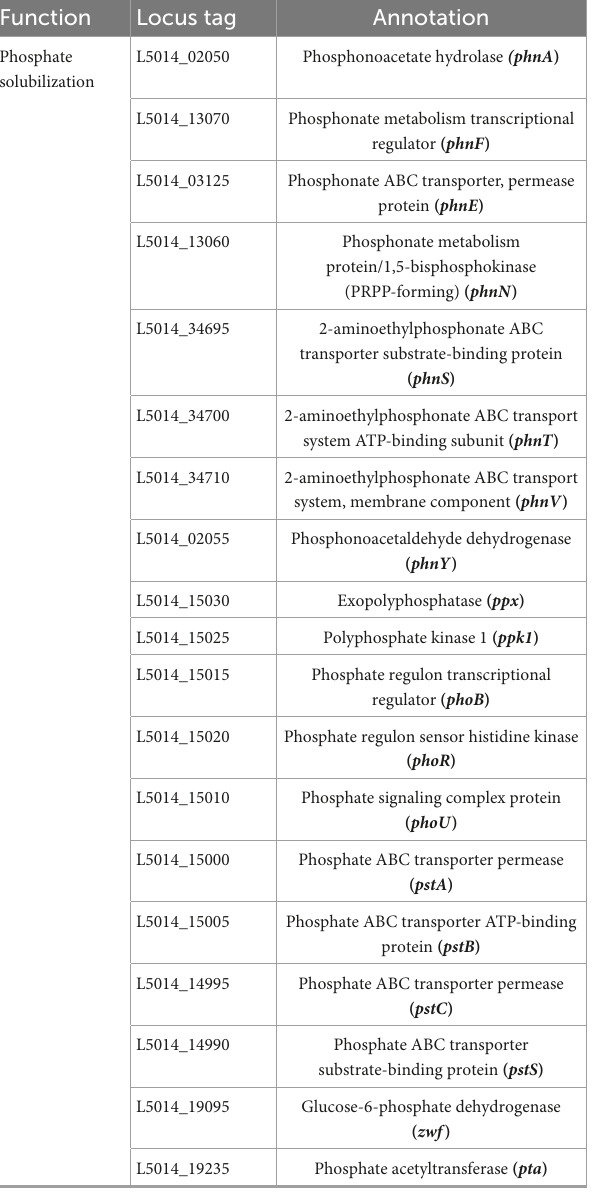
TABLE 2 Putative genes involved in phosphate solubilization in the genome of strain RG36 T .